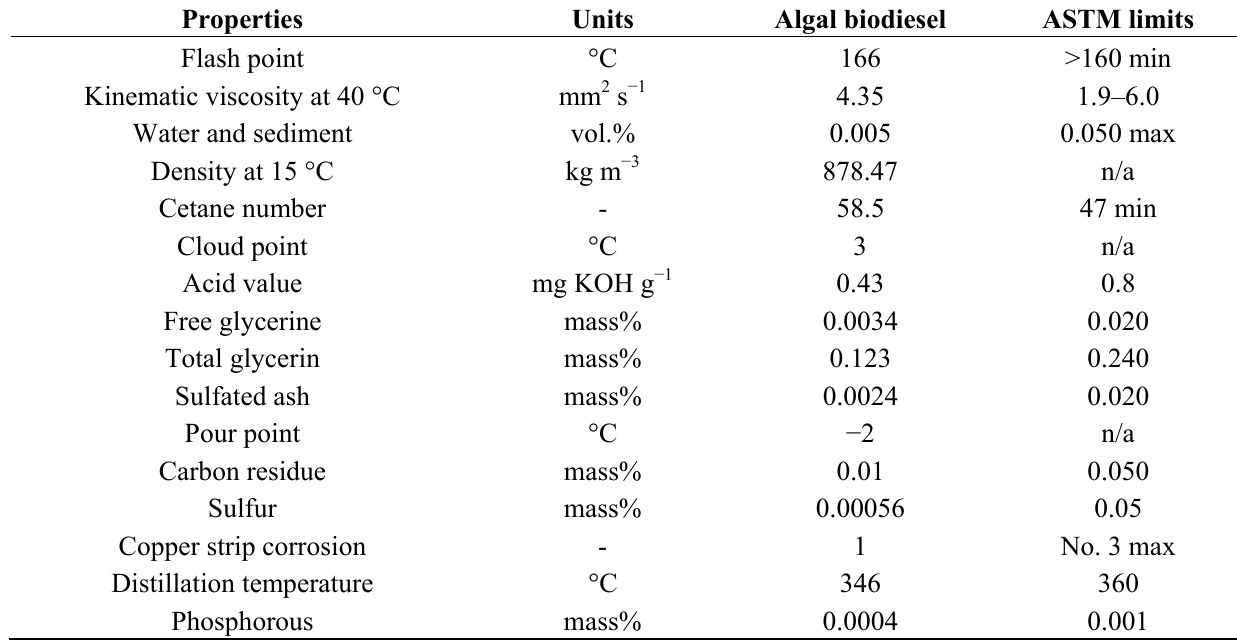
Table 5. Physicochemical characterization of algal biodiesel compared with American Society for Testing and Materials (ASTM) Standards (ASTM D 6751-06) [56].